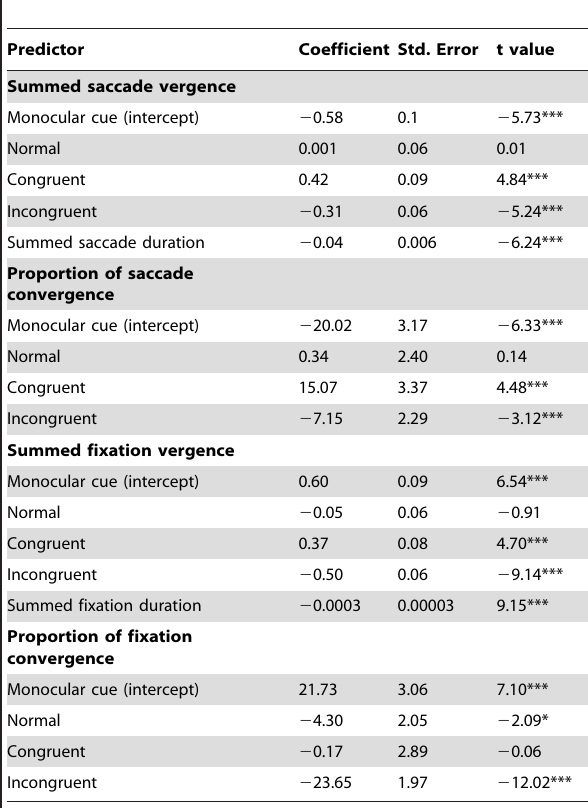
Table 3. Lme models for vergence during saccades and